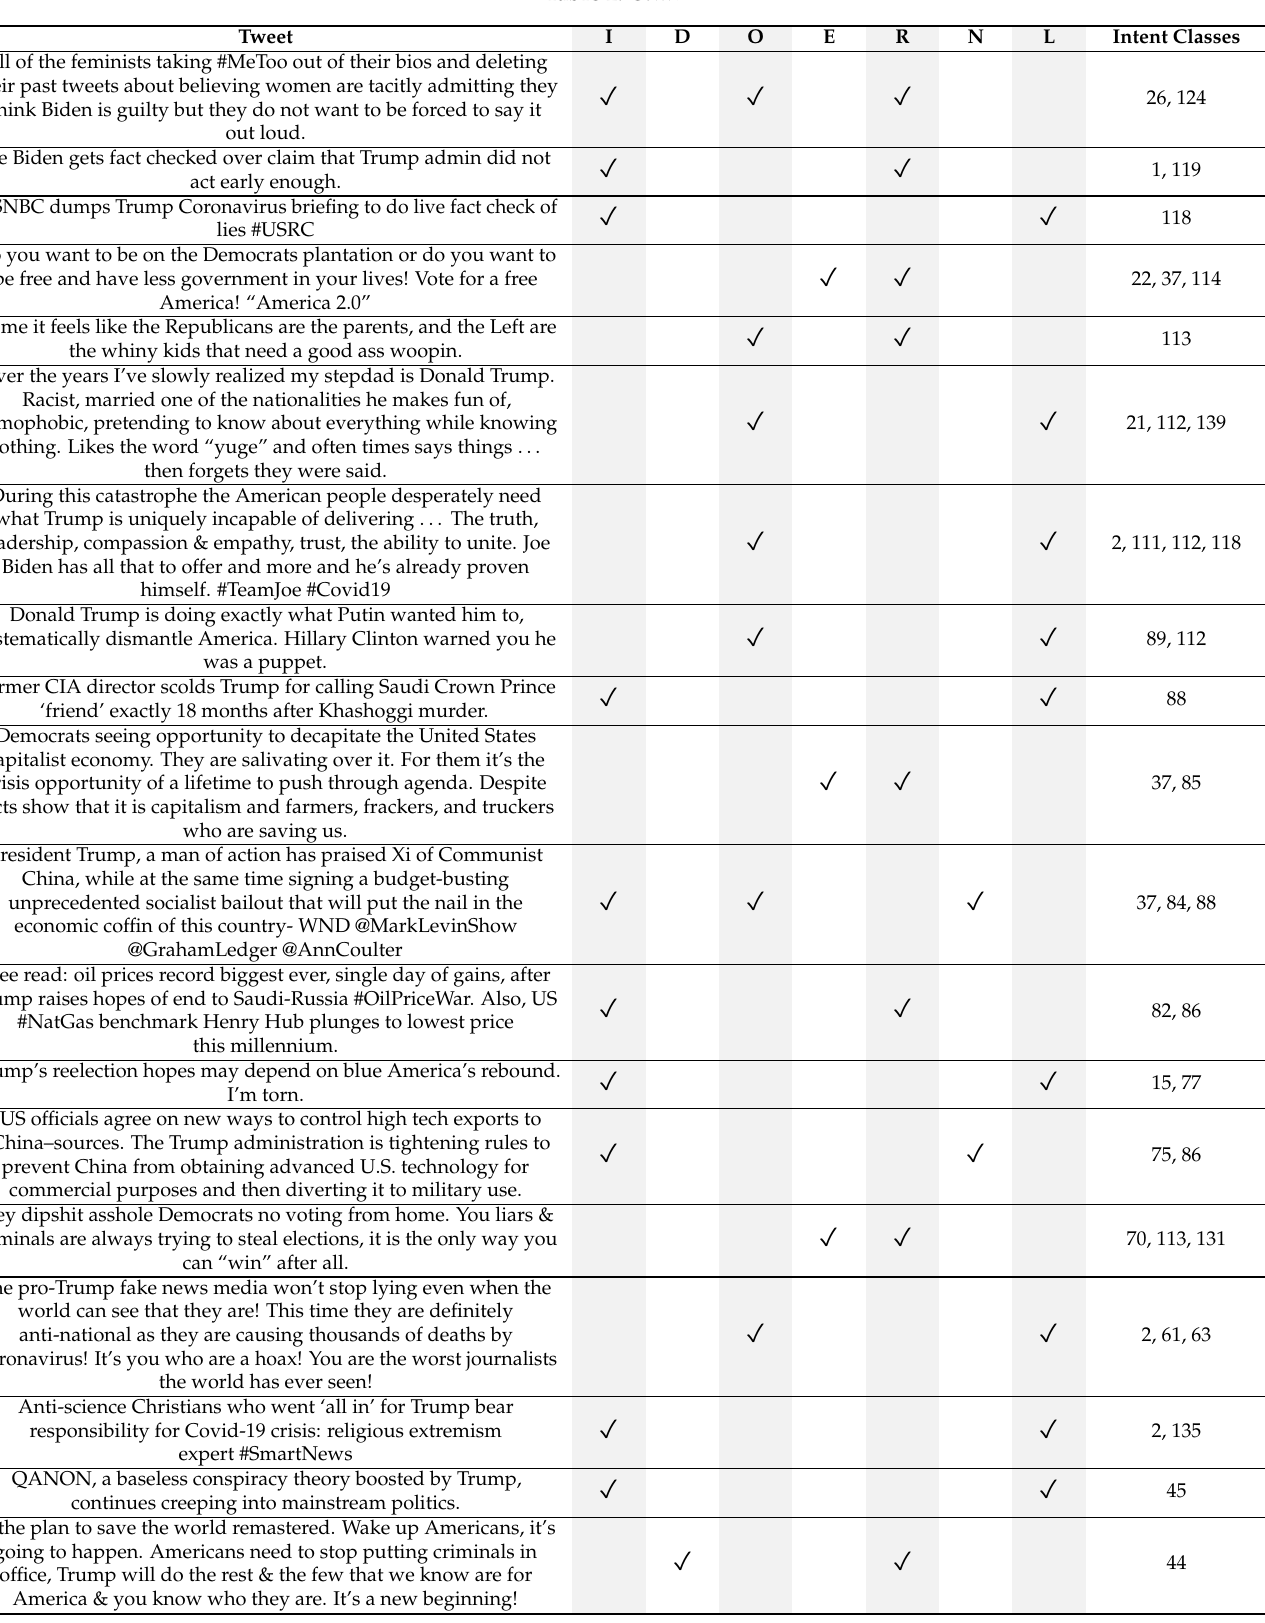
Table 2. Example Tweets and their classes: I stands for information, D for disinformation, O for opinion, E for extreme opinion, R for rightist, N for neutral, and L for leftist.